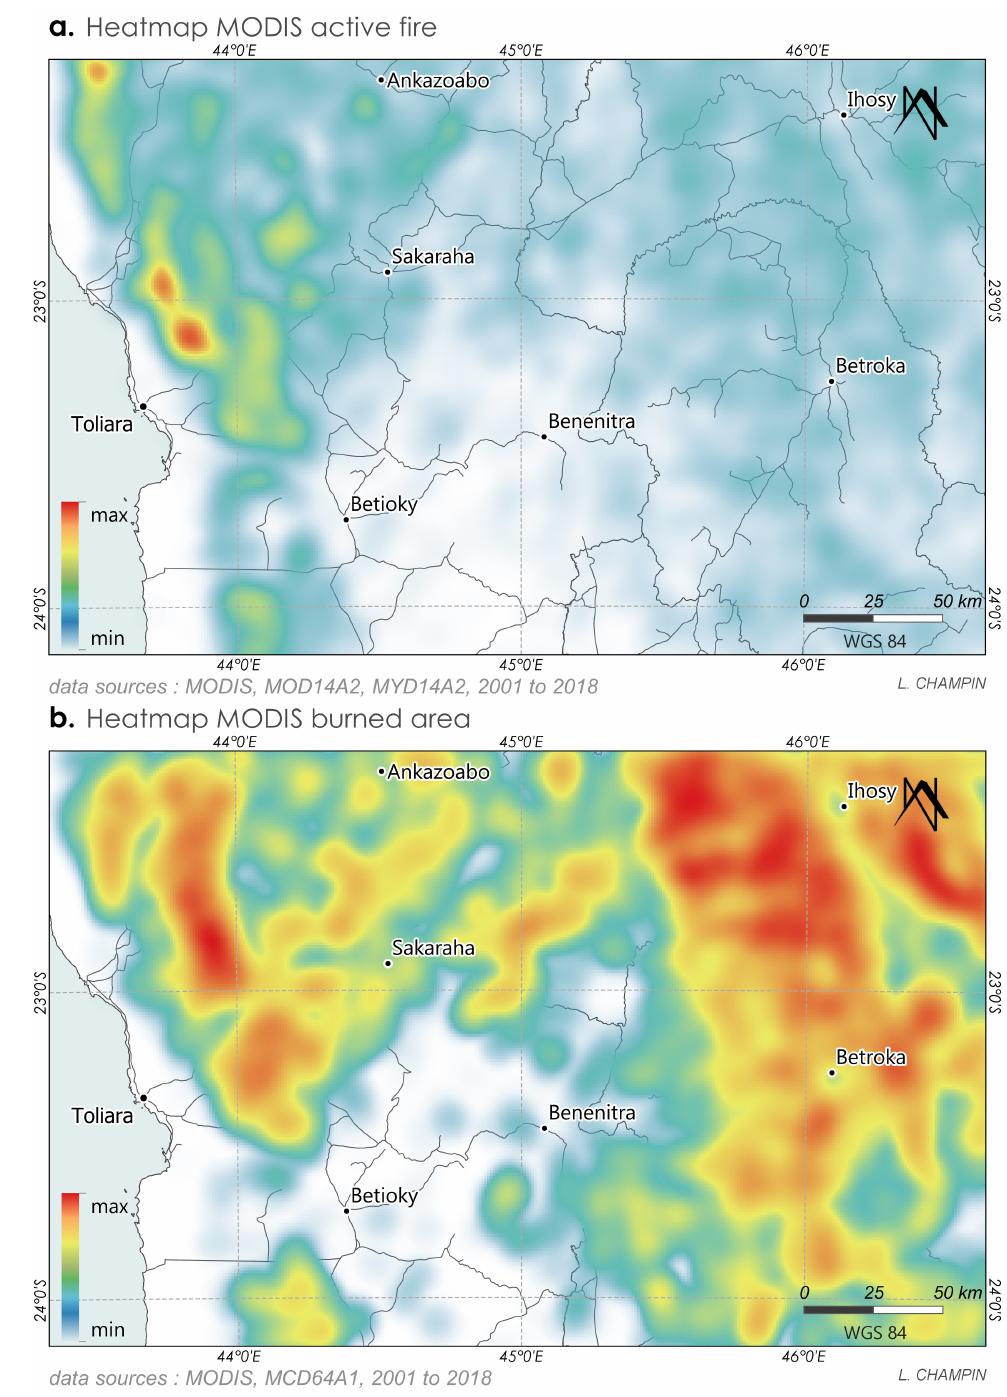
Figure 3. Fire density 2001 to 2018. ( a ) Heatmap from the MOD14A2 and MYD14A2 active fire data. ( b ) Heatmap from the MCD64A1 burned area